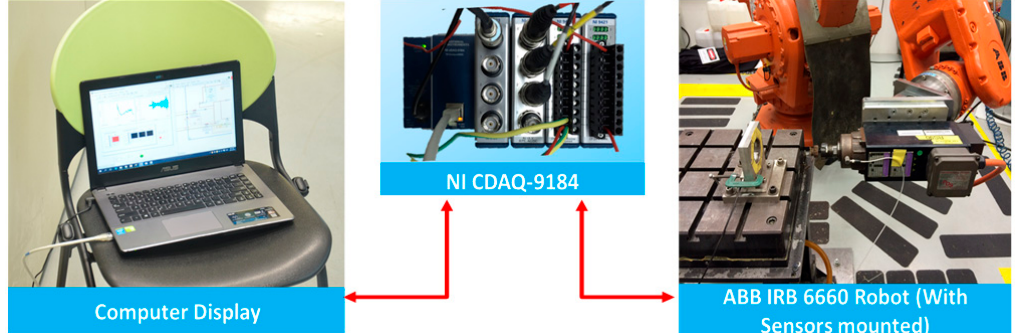
Figure 5. The data acquisition of the deburring process.